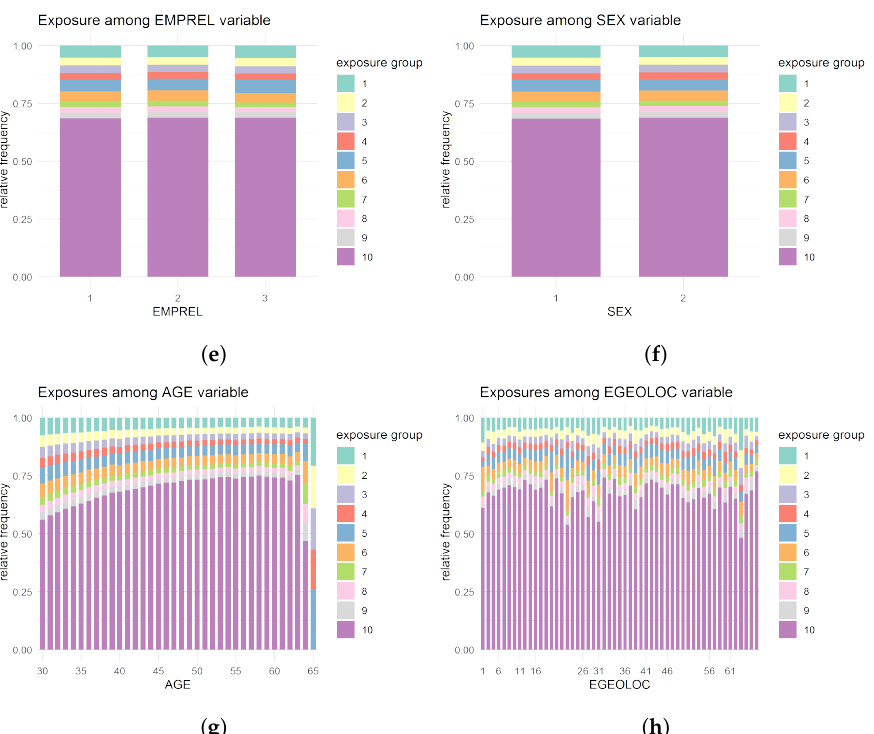
Figure 3. Distribution of exposure over different variables: ( a ) over PLANTYP variable; ( b ) over UR variable; ( c ) over EECLASS variable; ( d ) over EESTATU variable; ( e ) over EMPREL variable; ( f ) over SEX variable; ( g ) over AGE variable; ( h ) over EGEOLOC